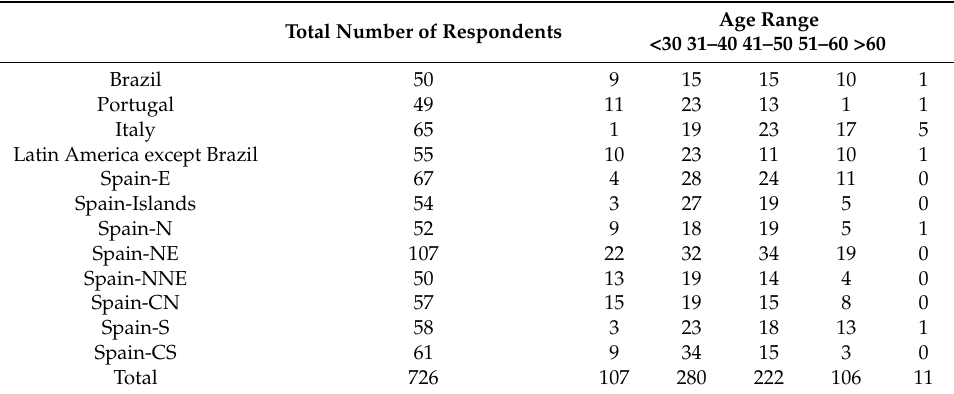
Figure 1. Number of responses by age and job category. Forest Ranger; Paid Firefighter; Volunteer Firefighter (includes Civil protection personnel and paid firefighters from units only occasionally involved in wildland fire suppression); Mid command (i.e., Mid Fire Chief (below Battalion Chief) or Mid Forest Manager or Mid Civil Protection Manager); Forest Manager; Faculty and Researcher; Fire Chief (i.e., Battalion Chief and up); and Others. Table 1. Number of responses by region and age.